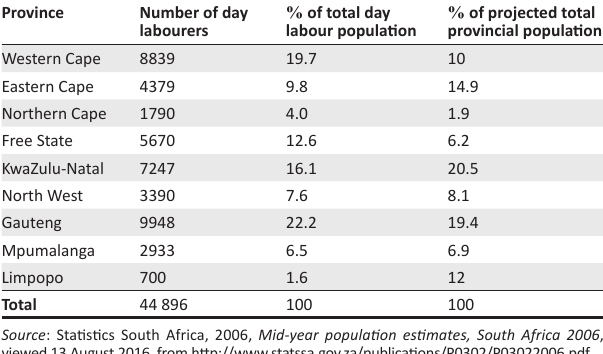
TABLE 1: Estimated number of day labourers in the nine provinces of South Africa, 2005‒2006.